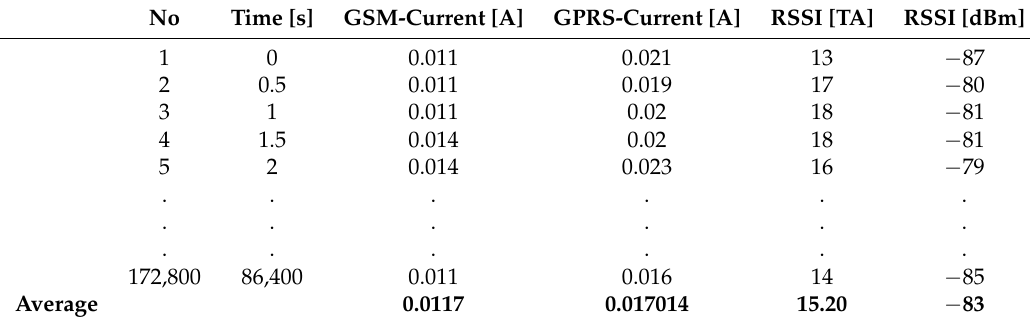
Table 5. Current consumption in location 2, RSSI = − 83